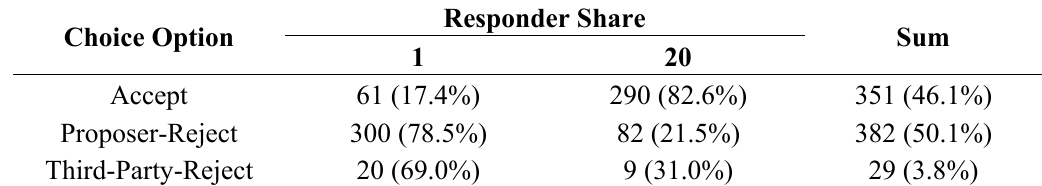
Table 1. Number and percentage of choices by responder share (Study 1; Percentages in columns ‘1’ and ‘20’ are row percentages per responder share; percentages in column ‘Sum’ are column percentages across choice options).